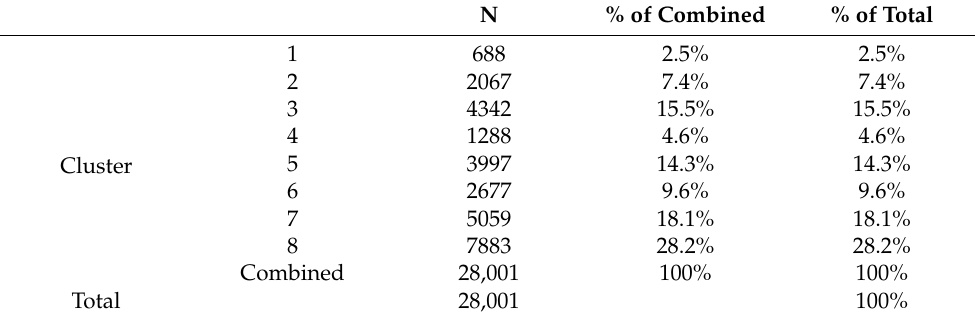
Table 3. Cluster